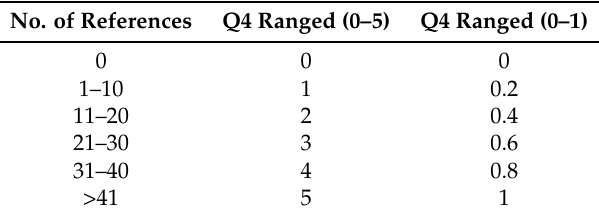
Table 5. Scoring of Q4 in case of review